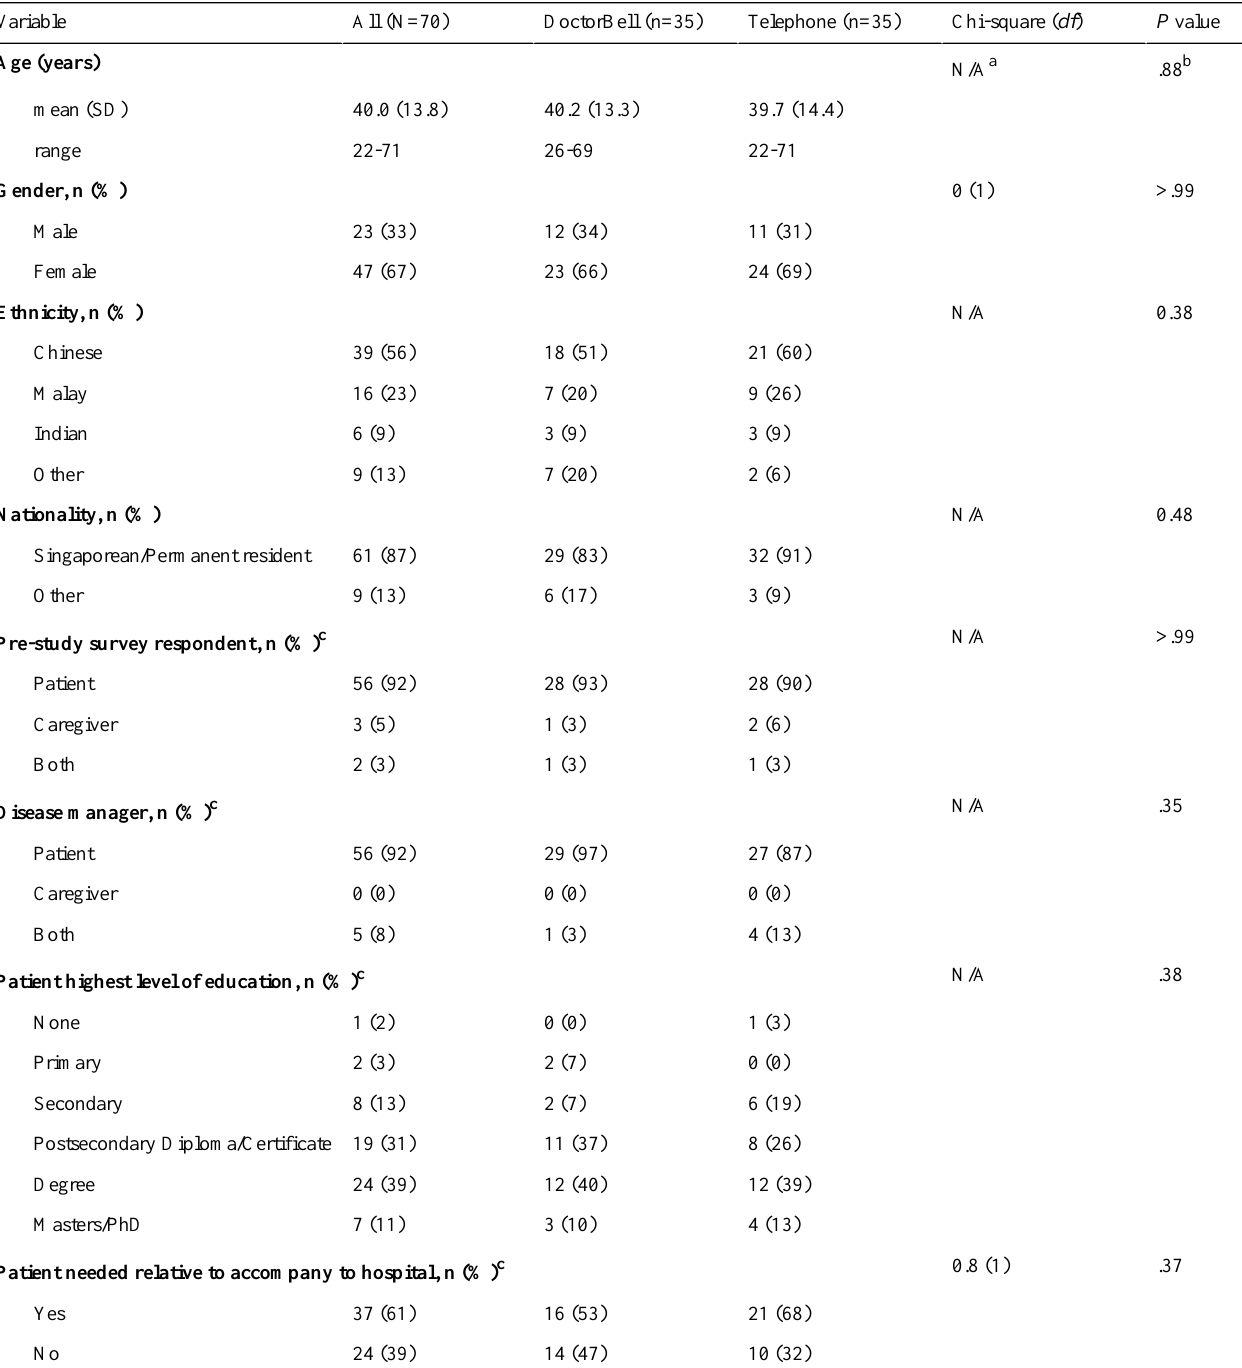
Table 1. Patient